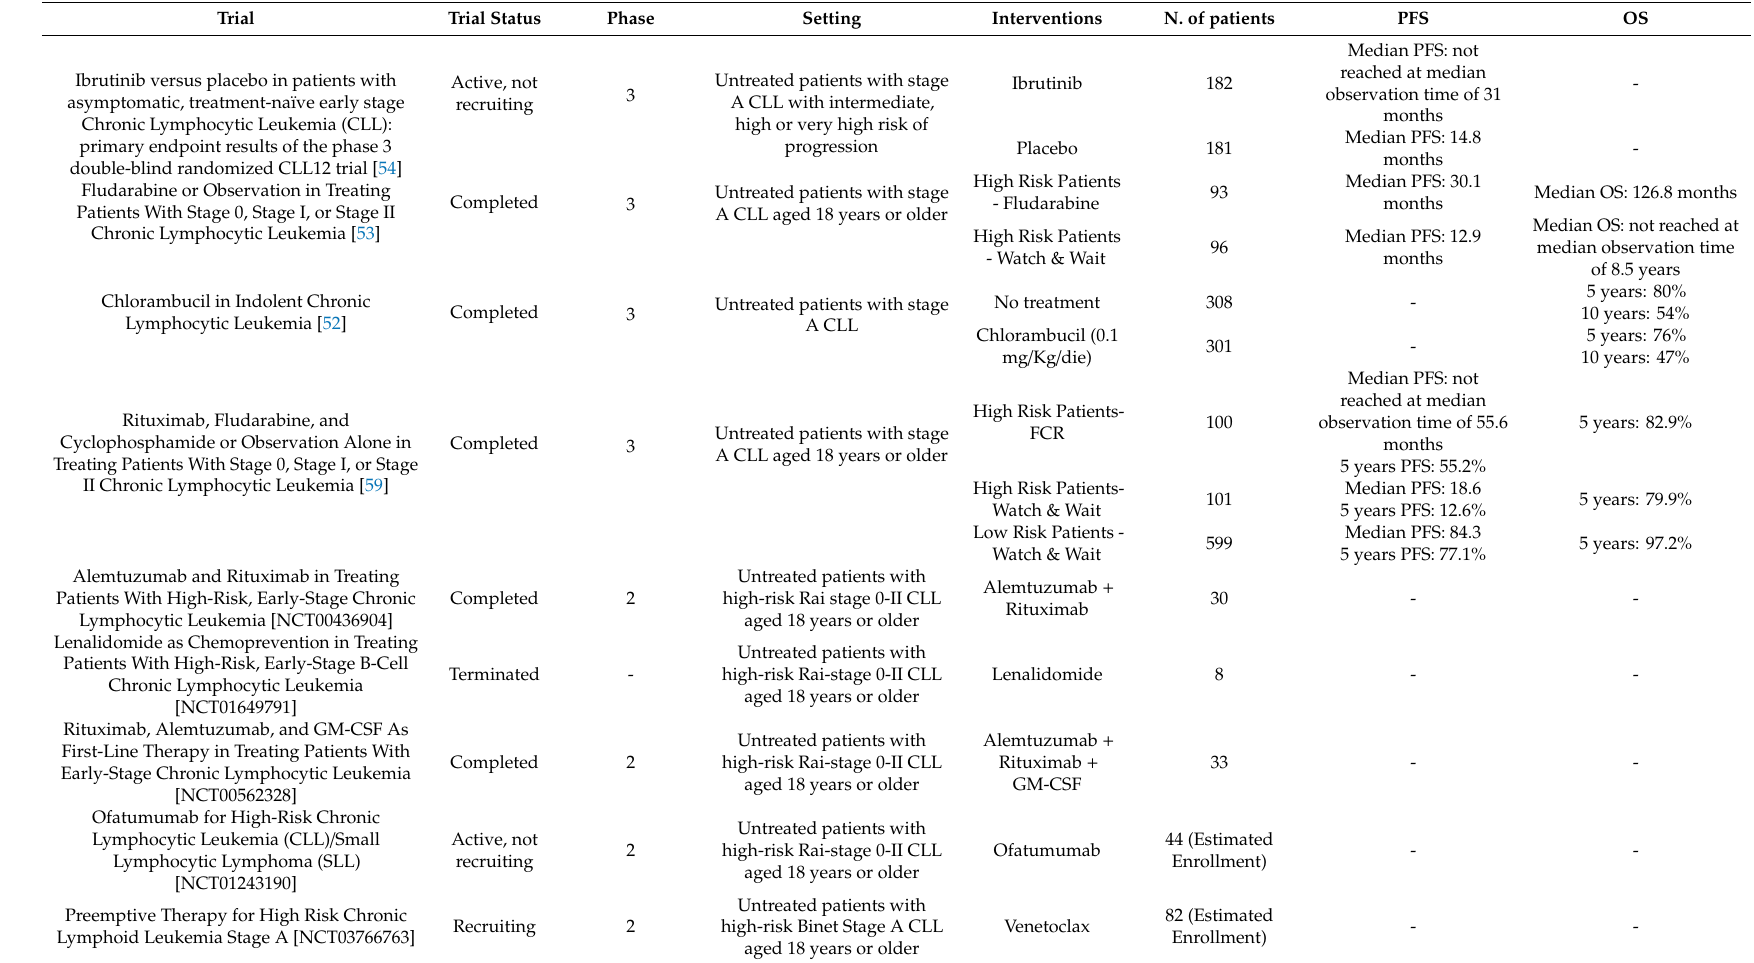
Table 1. Clinical trials in asymptomatic CLL